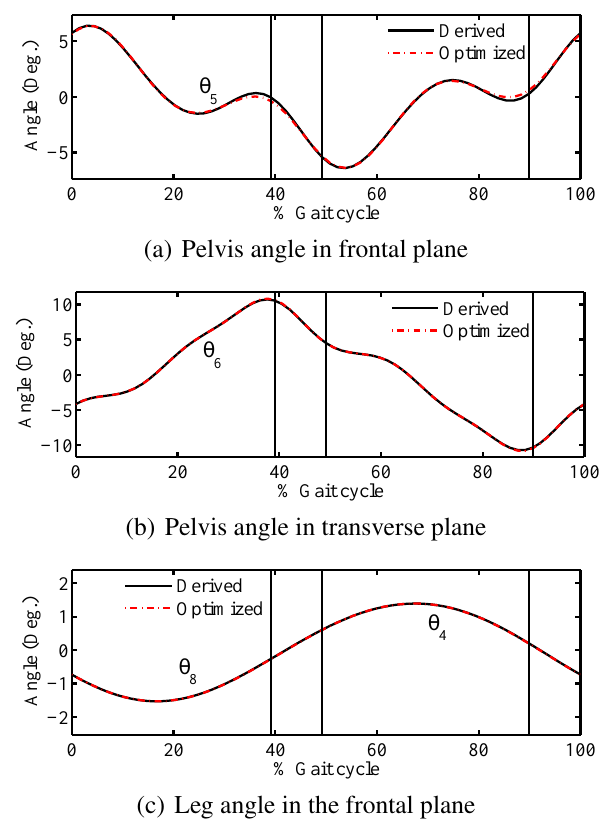
(c) Leg angle in the frontal plane Figure 5. Derived frontal plane and transverse plane kinematic data Figure 5. Derived frontal plane and transverse plane kinematic data for full gait cycle (toe-off to toe-off). Pelvis angles (a, b) in the for full gait cycle (toe-o ff to toe-o ff ). Pelvis angles (a and b) in the frontal and transverse planes and leg angle (c) in the frontal plane. frontal and transverse planes and leg angle (c) in the frontal plane. For (c) data from 0 to 39% gait cycle indicate data for the swing leg For (c) data from 0 to 39% gait cycle indicate data for the swing leg and data from 50 to 89% gait cycle indicate data for the stance leg and data from 50 to 89% gait cycle indicate data for the stance leg in the SS phase. in the SS phase. to Figure 4. Sagittal plane kinematic data for full gait cycle (toe-o ff toe-o ff ) (Winter, 2005). (a) Foot (b) Shank (c) Thigh and (d) HAT angles. For (a-c) the data from 0 to 39% gait cycle indicate data for the swing leg and angles from 50 to 89% gait cycle indicate data for the stance leg in the SS phase.